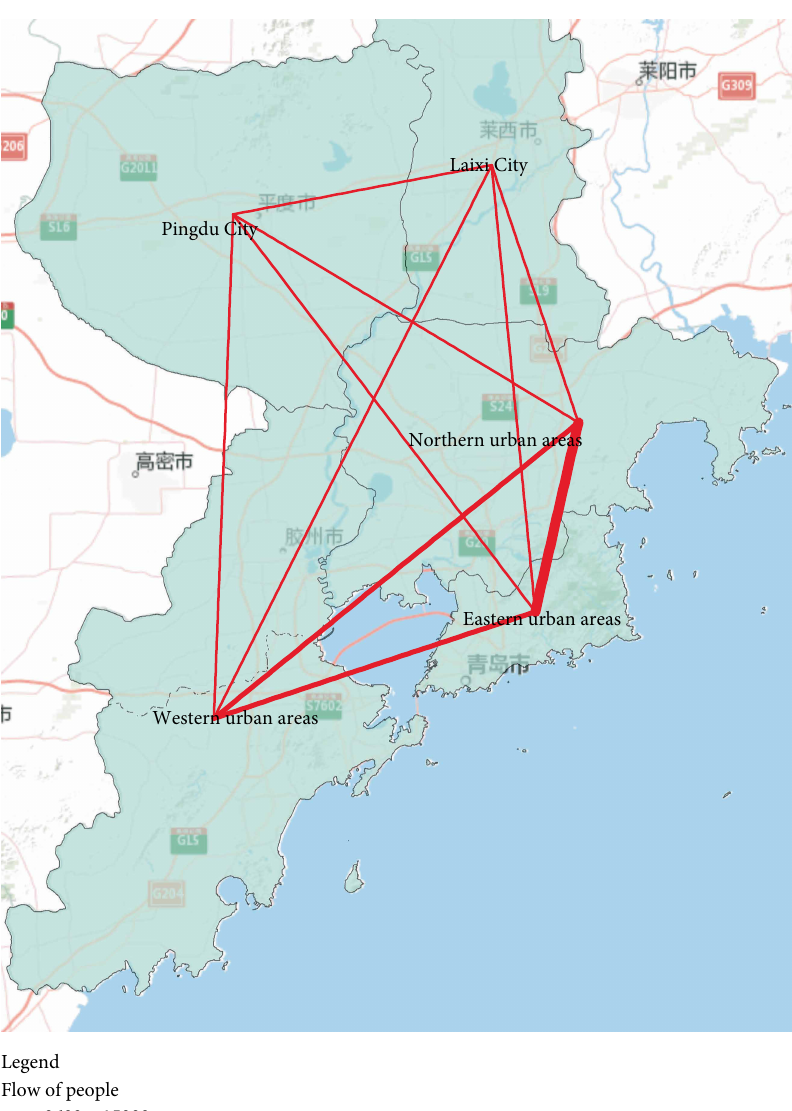
Figure 3: Linkage strength between different